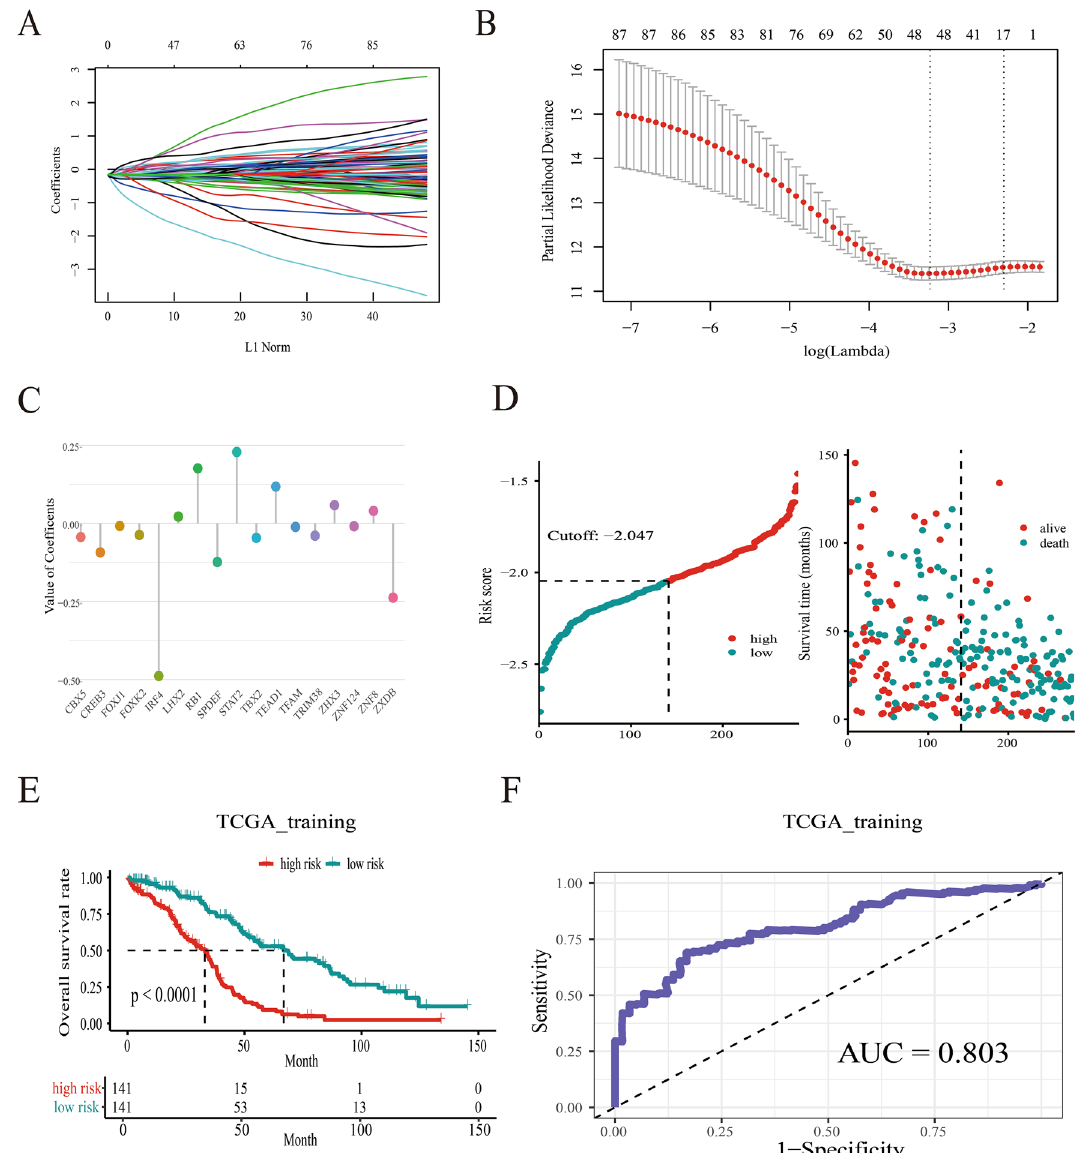
Figure 2. A 17-TFs related prognostic signature was established in TCGA training cohort. ( A – C ) The lasso coefficients of the 17 TFs for overall survival in TCGA training cohort; ( D ) The distribution of risk score and alive status in TCGA training cohort; ( E , F ) The 17-TF related prognostic signature predicts overall survival in SOC and the prediction performance was evaluated by calibration